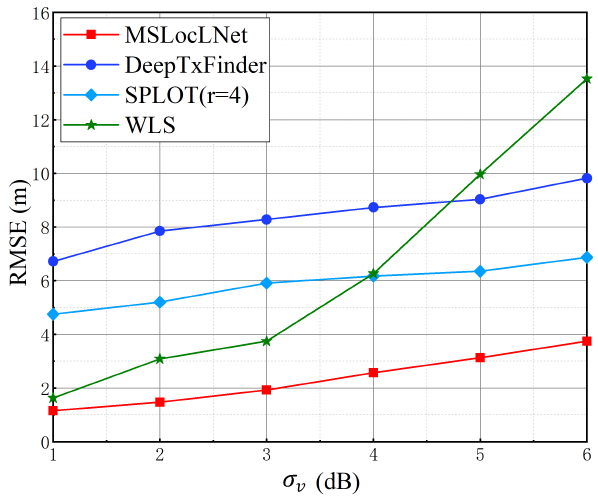
Figure 5. The RMSE for different σ .